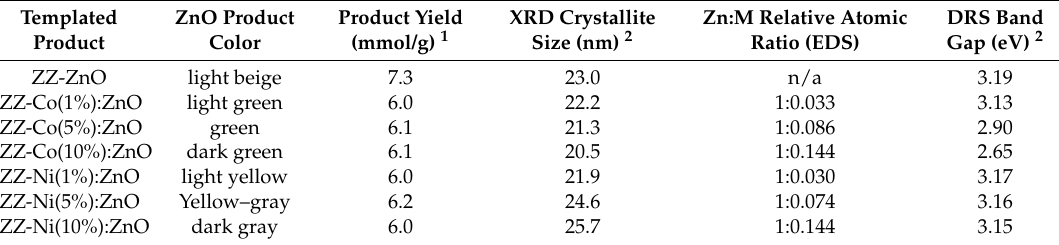
Table 1. Summary of key results for ZZ leaf templated ZnO